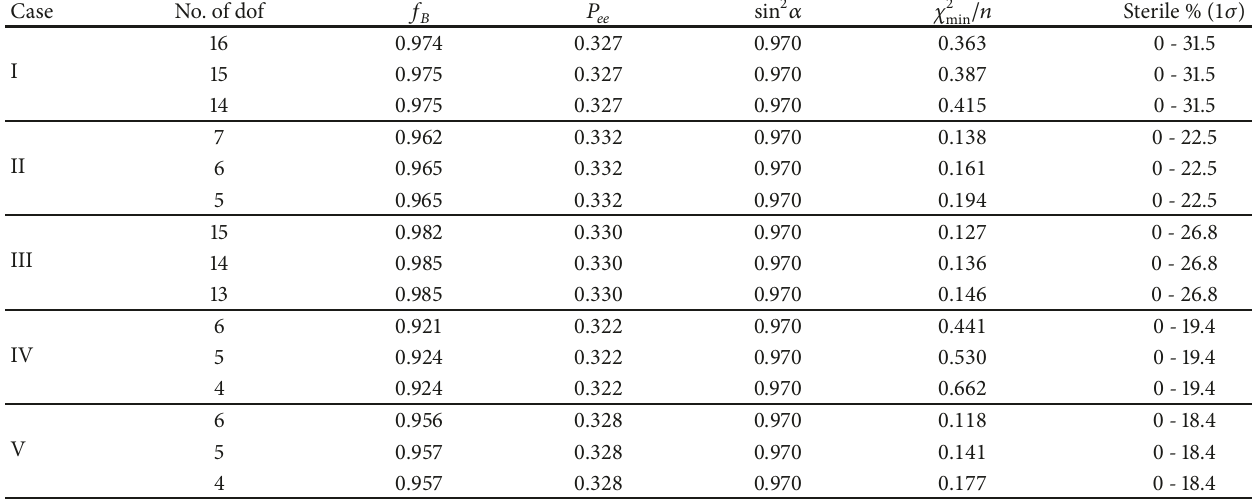
Table 9: Results of 𝜒 2 -analysis for all cases.